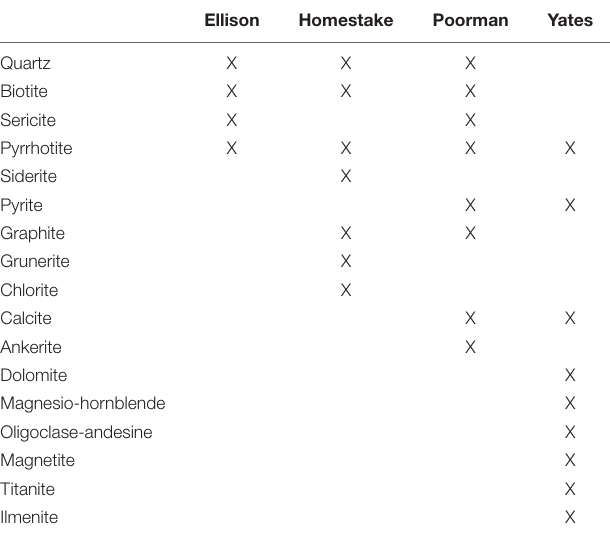
TABLE 1 | Major minerals present in DeMMO rock